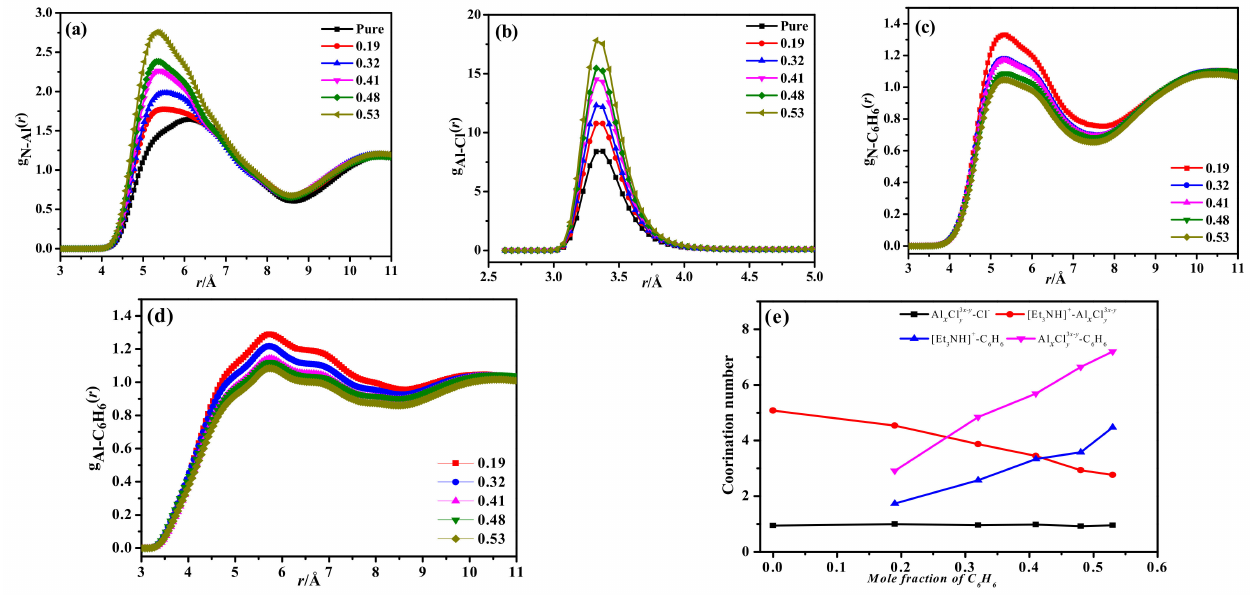
Figure 2. Radial distribution functions and coordination number from molecular dynamics. ( a ) [Et 3 NH] + -Al x Cl y3x − y , ( b ) Al x Cl y3x − y -Cl − , ( c ) [Et 3 NH] + - C 6 H 6 , ( d ) Al x Cl y3x − y -C 6 H 6 , and ( e ) coordination